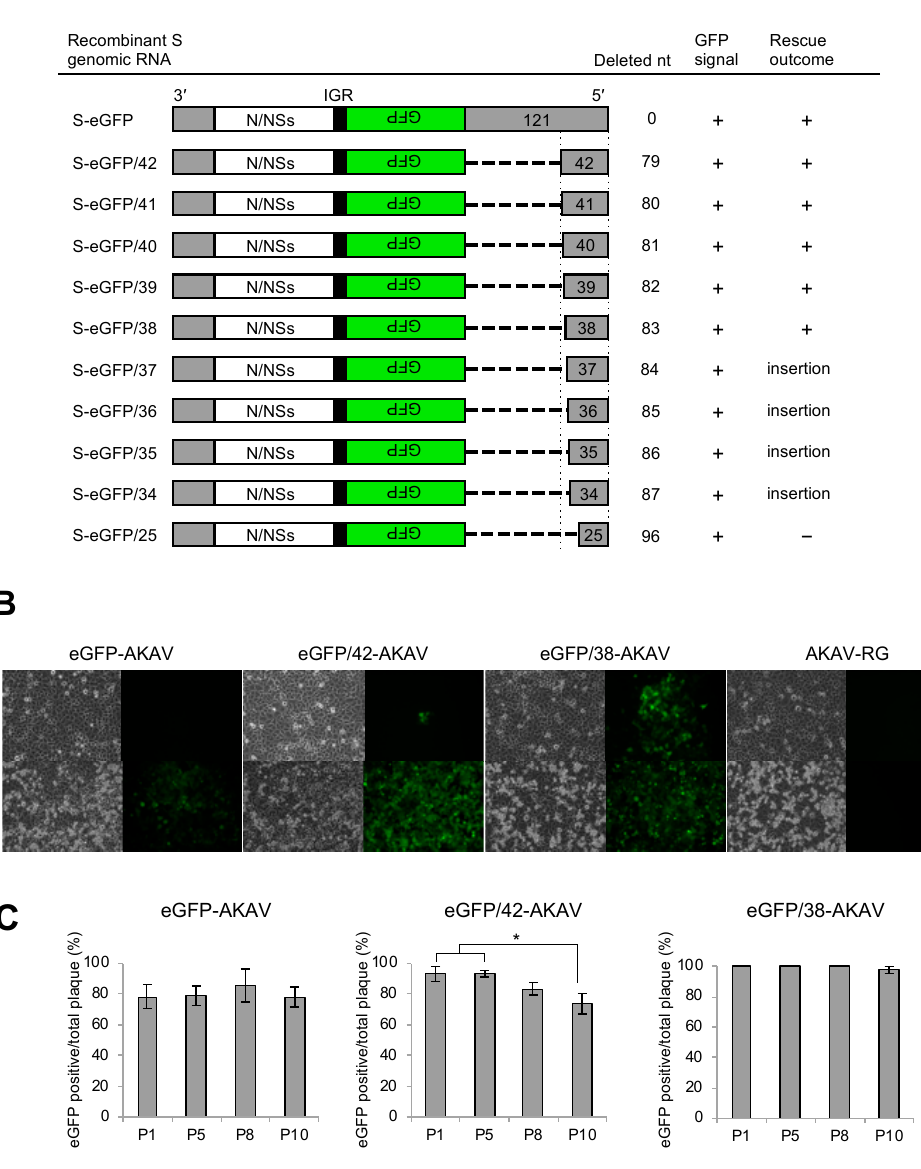
Figure 1. Generation and genetic stability of recombinant reporter Akabane viruses (AKAVs). ( A ) Schematic diagram of deletions introduced in the 5 ′ untranslated region (UTR) of the ambisense S segment are shown. Horizontal dotted lines indicate deleted regions. Gray bars represent the UTR on each side. White and green bars represent the nucleocapsid negative sense (N / NSs) and green fluorescent protein (GFP) coding regions, respectively. Black bars represent the intergenic region (IGR) of Rift Valley fever virus (RVFV). + denotes enhanced green fluorescent protein (eGFP) expression in transfected cells. - denotes no rescue of recombinant virus by reverse genetics. “insertion” denotes the presence of unexpected insertion sequences in the S 5 (cid:48) UTR of the rescued viruses. ( B ) Cytopathic e ff ects (CPE) and eGFP expression in cells infected with parent eGFP-AKAV, deletion viruses (eGFP / 42- and eGFP / 38-AKAVs), and wild-type AKAV-RG are shown. Panels on the left are images with bright field and panels on the right are fluorescence images. ( C ) To assess the genetic stability of eGFP-, eGFP / 42-, and eGFP / 38-AKAVs, they were passaged 10 times in HmLu-1 cells. At passages 1, 5, 8, and 10, viruses were subjected to a plaque assay. The numbers of total and eGFP-positive plaques were determined. The results are presented as the mean ± SD (error bars) from 4–5 wells. *, p < 0.01; Mann–Whitney U